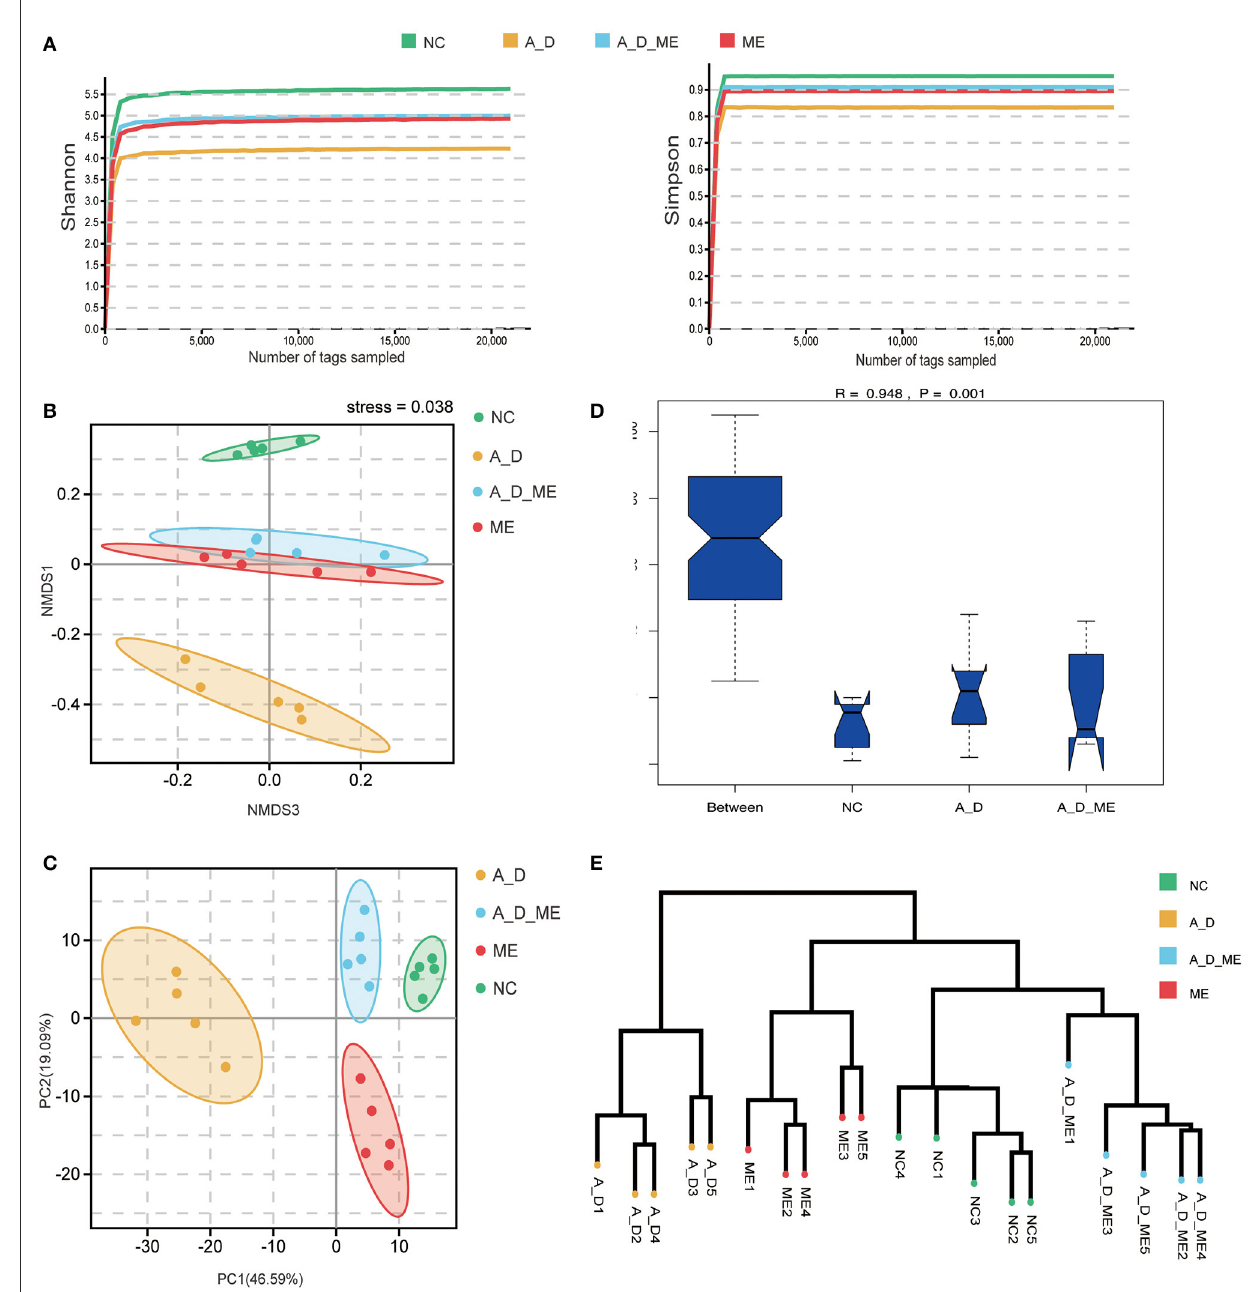
FIGURE5 Effects of ME intragastric administration on microbial diversity in intestinal fetal, decided by 16s rRNA sequencing. (A) rarefaction curves of Shannon and Simpson index, (B, C) plots of nonmetric multidimensional scaling (NMDS) analysis, and Principal Component Analysis (PCA) based on weighted unifrac distance. The more similar the sample had, the closer the distance reflected in the plot. (D) boxplot of analysis of similarity (ANOSIM) based on weighted_unifrac among the three groups, NC vs. A_D R = 0.996 p < 0.05*, A_D vs. A_D_ME R = 0.776, ** p < 0.01, (E) UPGMA clustering method of all samples was classified on the basis of the unifrac-distance matrix, R = 0.948, ** p < 0.01. The more similar samples had shorter common